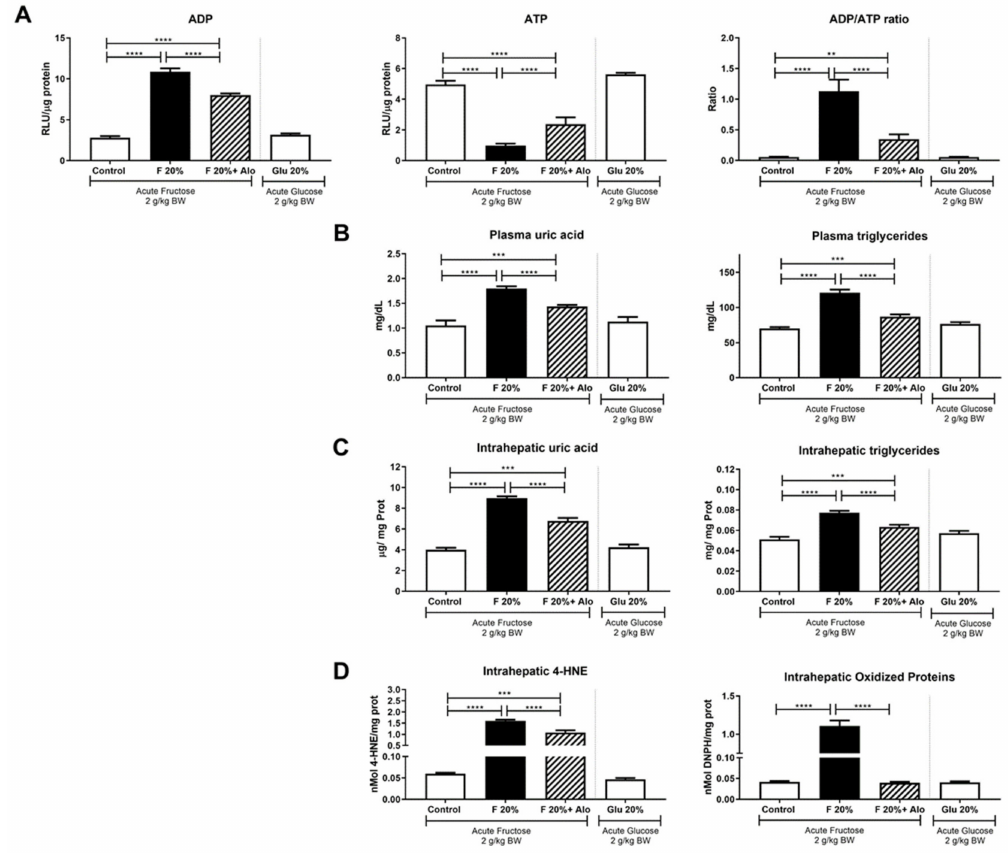
Figure 1. E ff ect of an acute load of fructose in short-term high fructose fed fasted rats. ( A ) An acute load of fructose (2 g / kg BW) induced a significant increase in hepatic ADP in parallel with ATP depletion, thus increasing ADP / ATP ratio. Allopurinol treatment prevented such e ff ect. ( B ) Plasma and ( C )